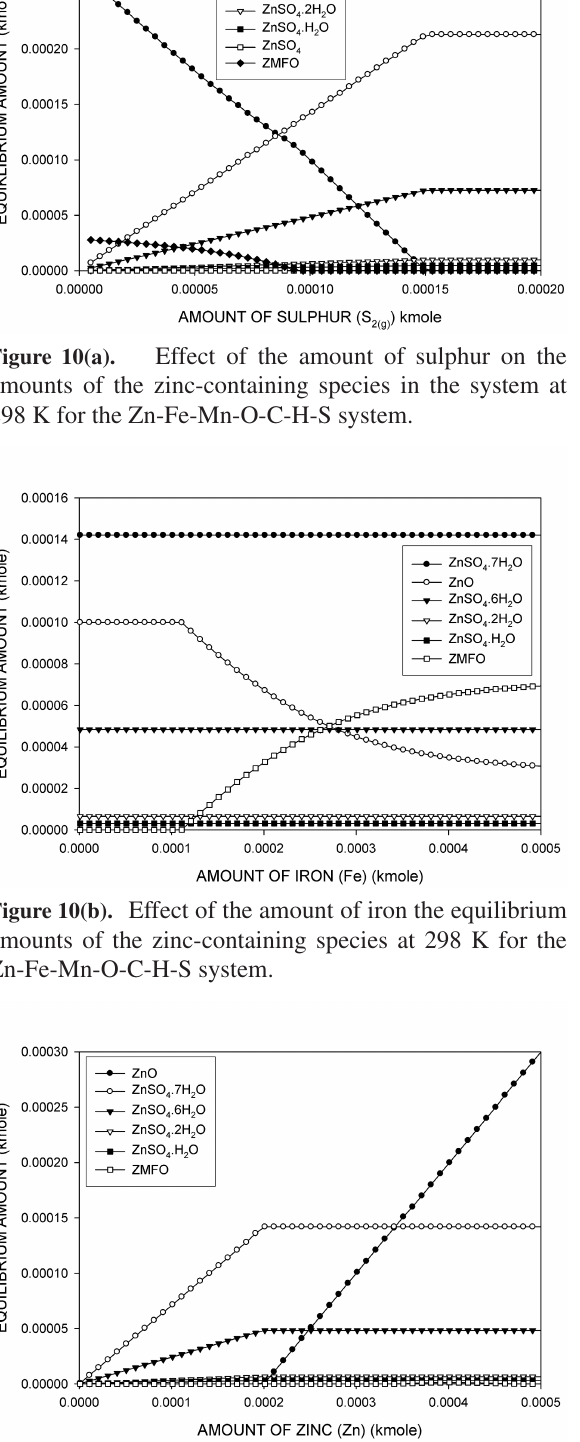
Figure 10(c). Effect of amount of zinc on the equilibrium amounts of the zinc-containing species at 298 K for the Zn-Fe-Mn-O-C-H-S system.